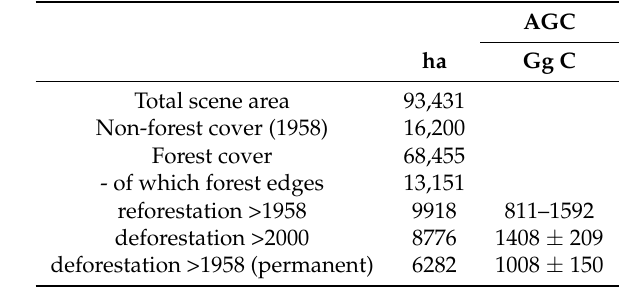
Table 3. Land-use land-cover change statistics of forest cover around Yangambi in the central Congo Basin: The data evaluates a difference between a historical (1958) aerial photography-based survey and the Hansen et al. 2013-based satellite remote sensing data. Spatial coverage statistics are provided hectares (ha), rounded to the nearest integer as well as Above Ground Carbon (AGC) scaled using recent survey measurements. Both non-forest cover in 1958 and the forest edge area are subsets of the original data (see Figure 5) and do not count toward the total scene area.